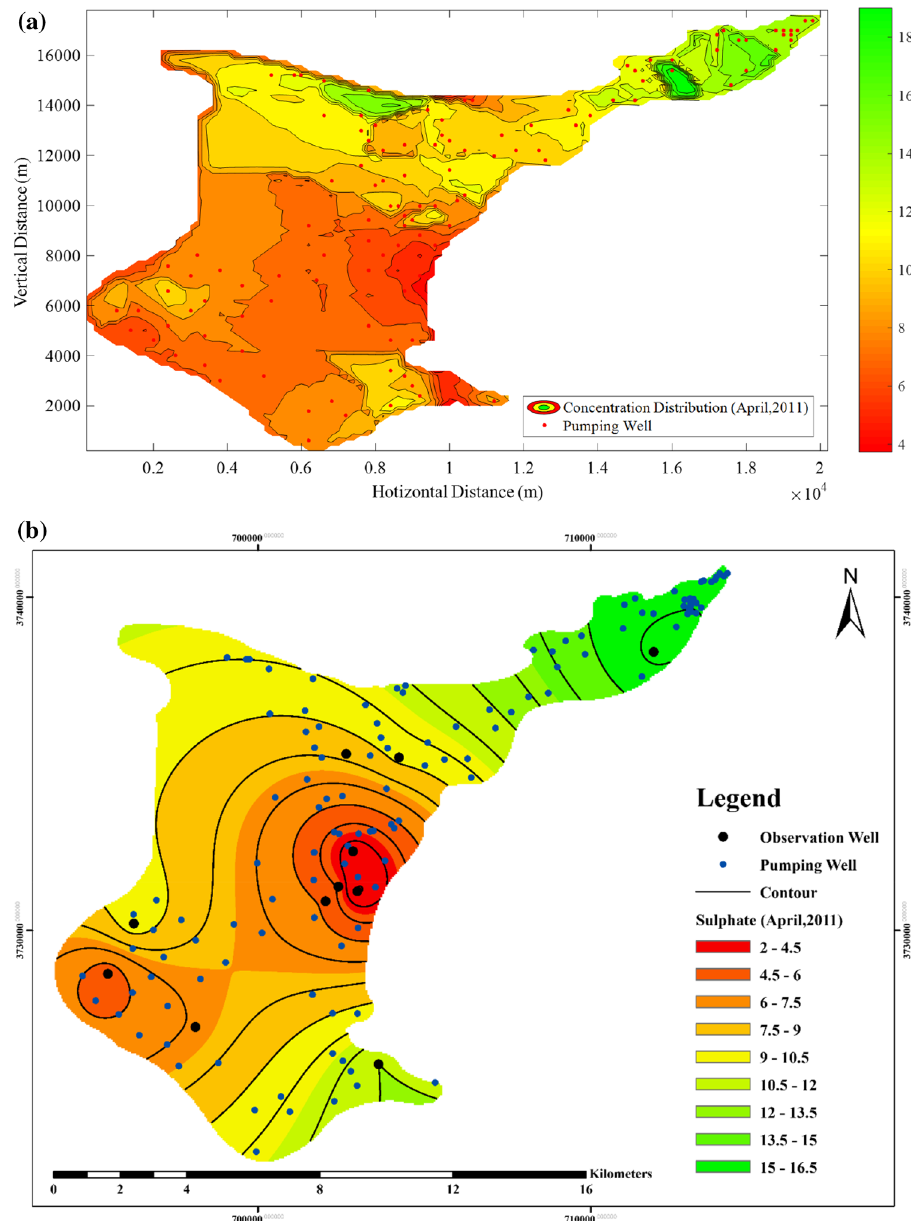
Fig. 12 Sulfate contamination contour lines (2011) a from the model b interpolated using